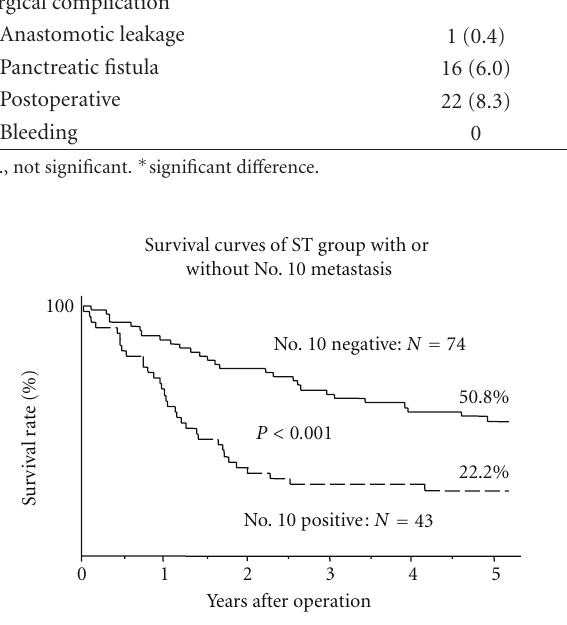
Figure 3: Comparison of cumulative survival curves of ST group between with or without No. 10 metastasis. The prognosis of the patients with No. 10 positive was poorer than that of the patients with No. 10 negative ( P < 0 . 001).